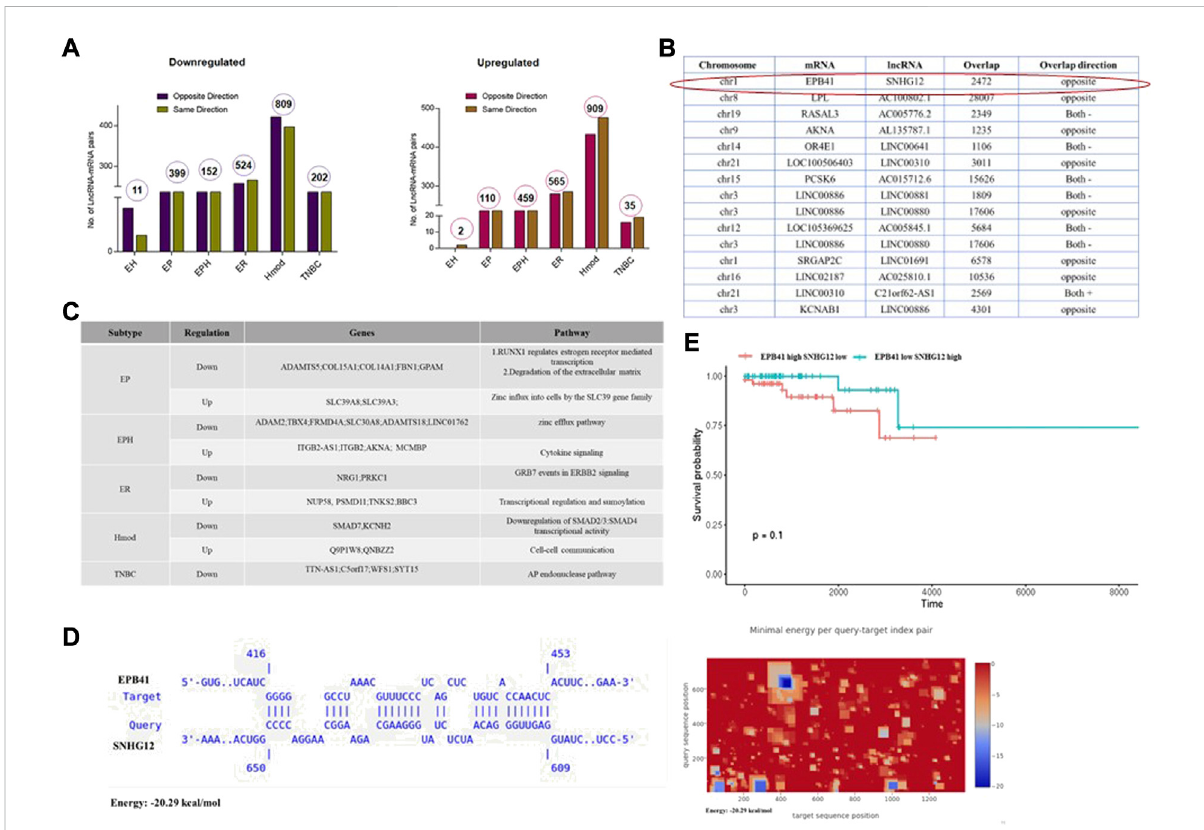
FIGURE 6 (A) Bar graphs depicting number of lncRNA-mRNA pairs in different subtypes of Indian breast cancer patient samples. (B) Table shows lncRNA and its corresponding mRNA pair obtained from different subtypes that are common to all the patients in the group. (C) Table depicting subtype- speci fi c pathways obtained from lncRNA-mRNA pairs. (D) A potential binding site between EPB41 (Target) and SNHG12 (Query) was identi fi ed by IntaRNA. The heat map shows potential binding sites between EPB41 and SNHG12 in blue. (E) Survival plot for high and low SNHG12 and EPB41 levels in the TCGA data